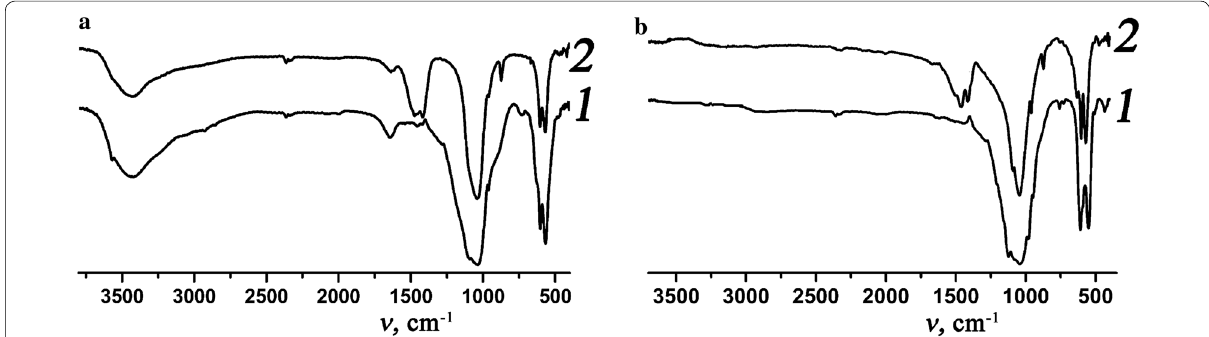
Fig. 2 FTIR-spectra for samples III (curves 1) and IV (curves 2) dried at 80 °C ( a ) and heated to 700 °C ( b